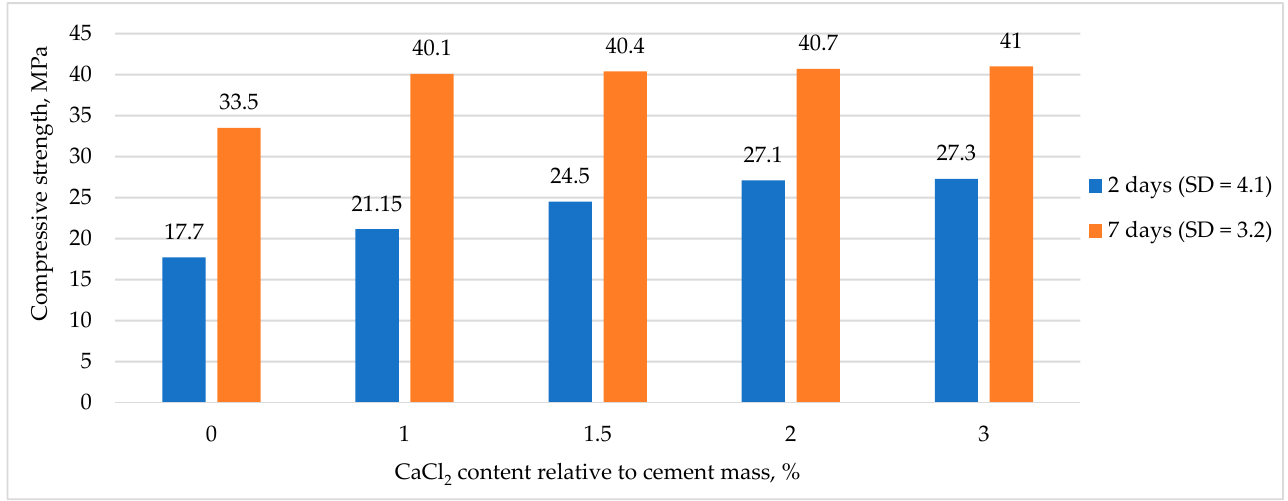
Figure 9. The e ff ect of CaCl 2 amount on RHC strength gain.